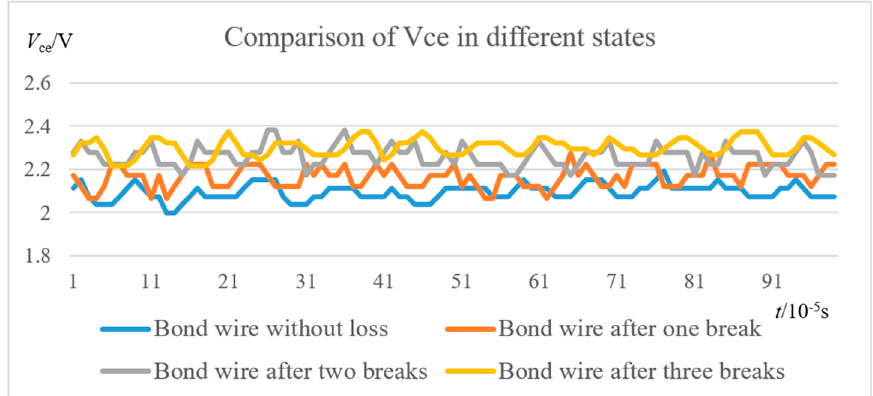
Figure 11. Comparison of V ce in different states.